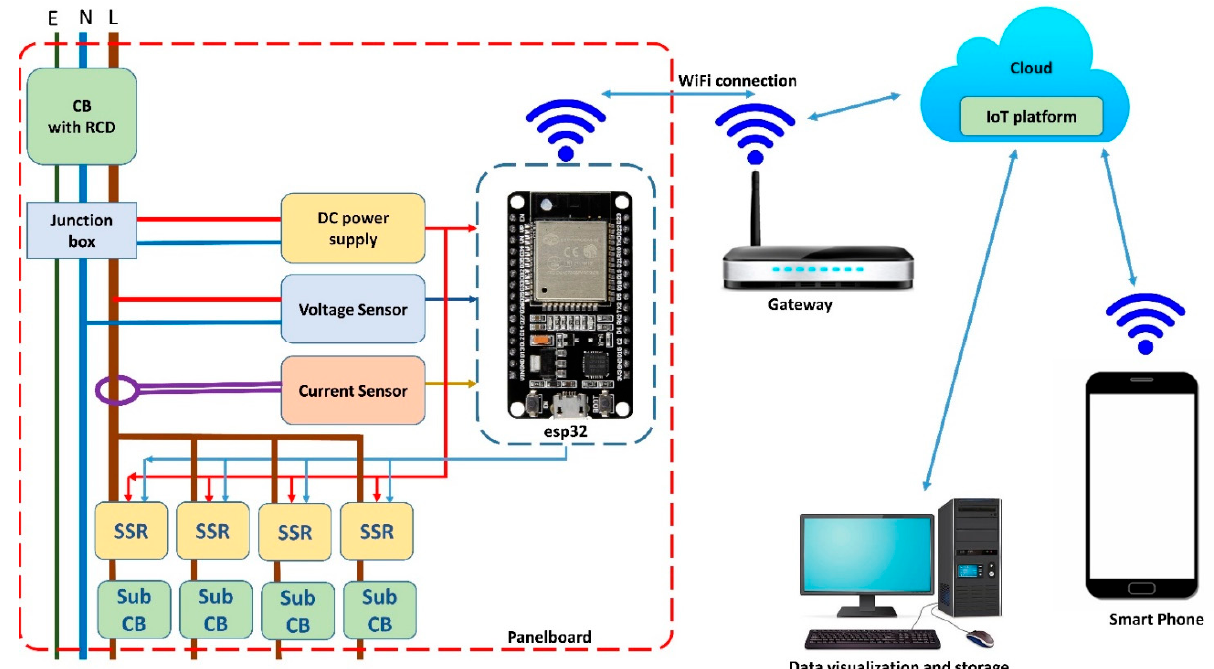
Figure 1. Proposed architecture of the smart DPB.